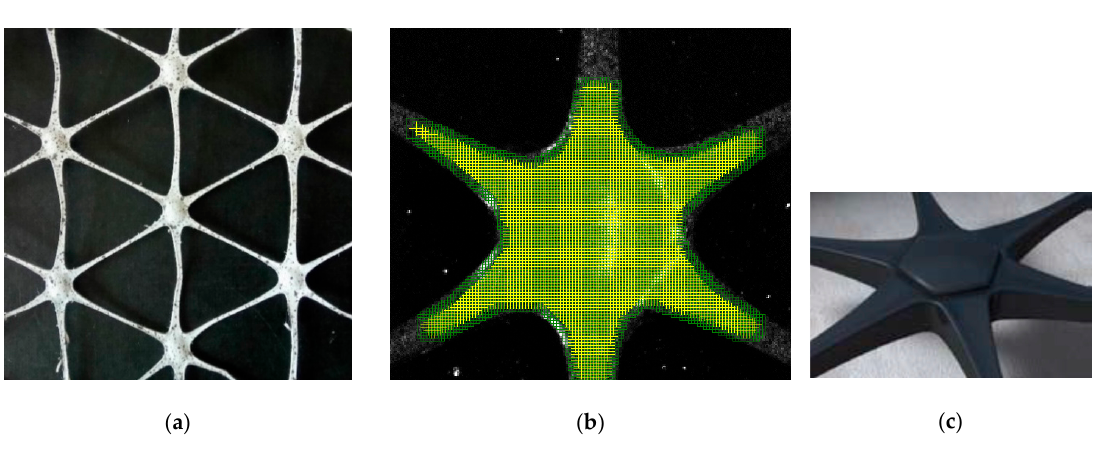
Figure 19. Vertical strains of biaxial geogrids: ( a ) Maps of the distribution of vertical strains on the surface of the glass fibre geogrid sample; ( b ) maps of the distribution of vertical strains on the surface of the polyester geogrid sample [52].